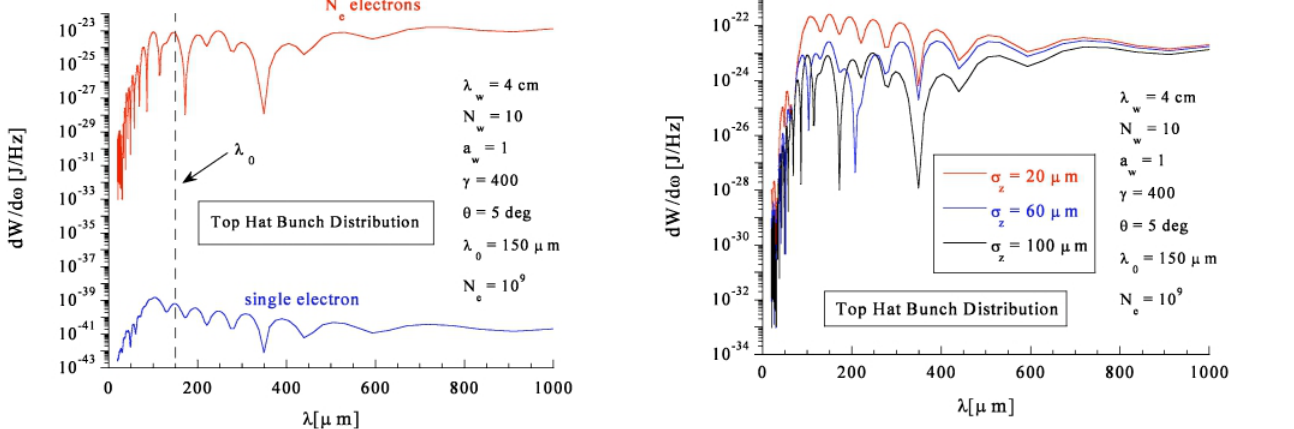
FIG. 7. (Color) Energy spectrum for a top hat bunch distribu- tion. The electron bunch has an rms length s z (cid:1) 100 m m.